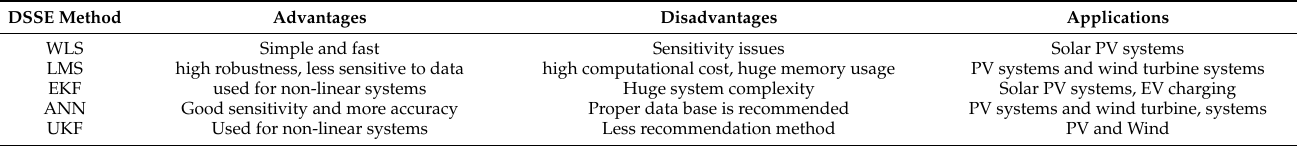
Table 2. Advantages, disadvantages, and applications of various DSSE